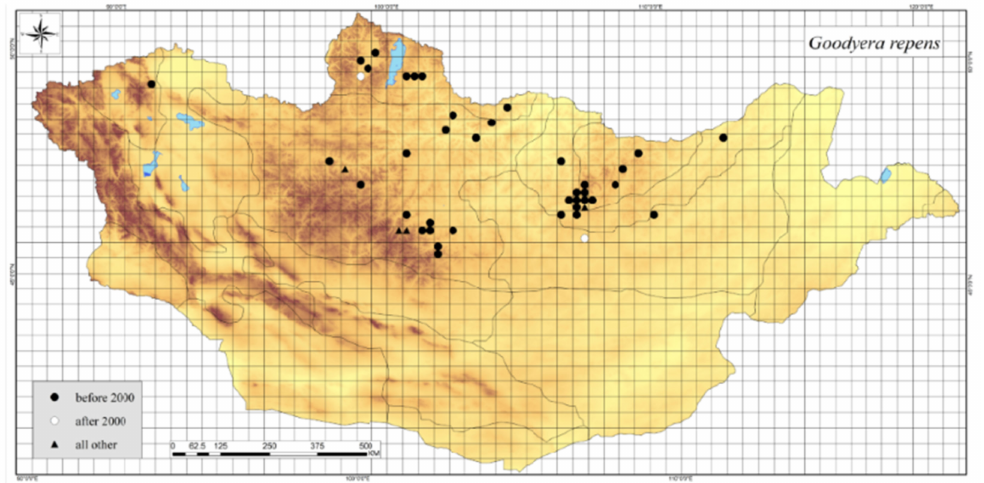
Figure A14. Distribution map of Goodyera repens in